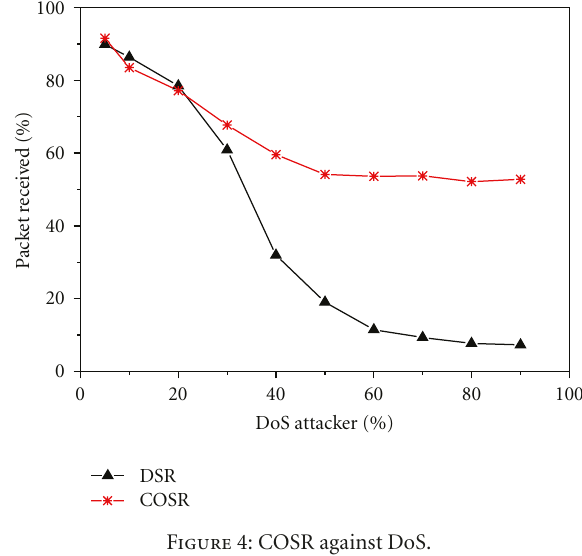
Figure 3: COSR against blackhole and selfish.